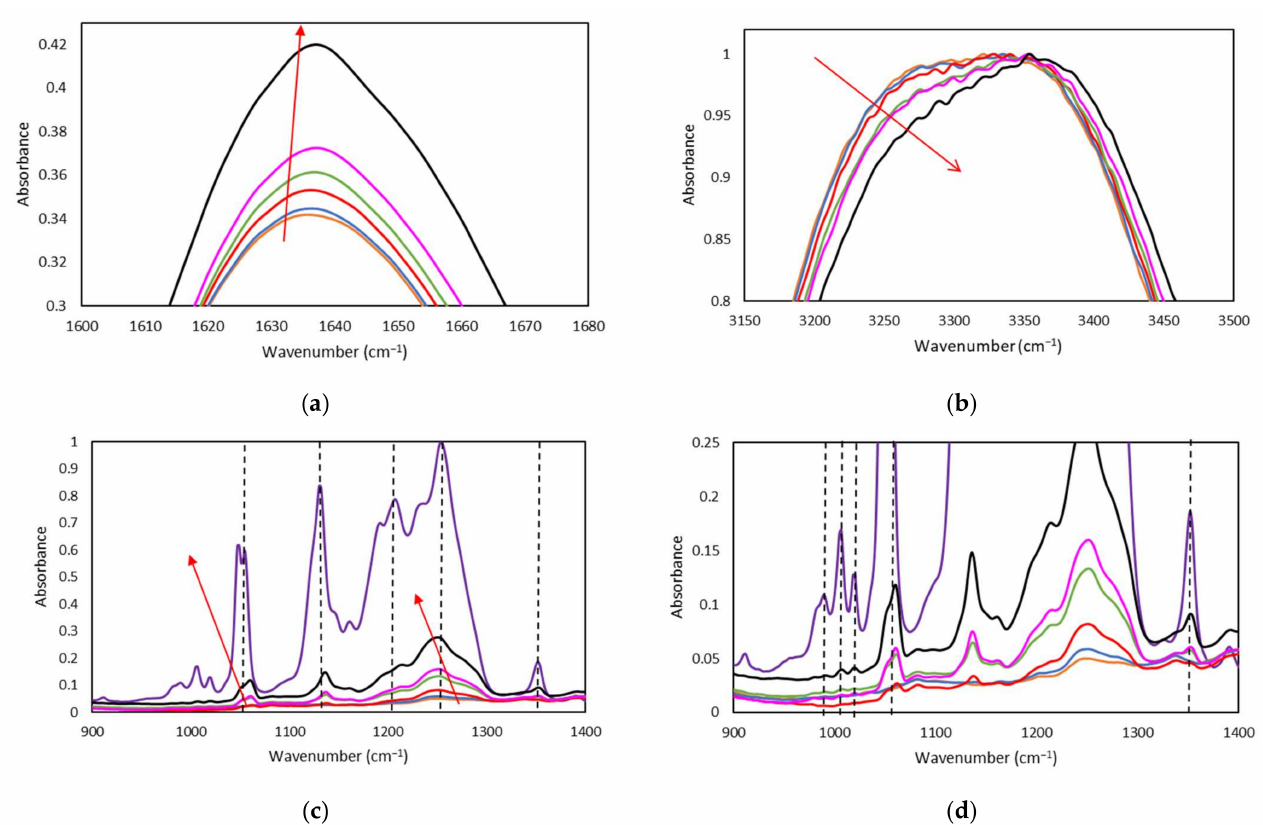
Figure 10. FTIR spectra of the Ionogels. Secondary structure 1600–1700 cm − 1 region ( a ), 3150–3500 cm − 1 region; ( b ) 900–1400 cm − 1 region; ( c , d ) of: ( — ) GE, ( — ) GE/1IL, ( — ) GE/5IL, ( — ) GE/10IL, ( — ) GE/15IL, ( — ) GE/25IL and ( — ) IL.